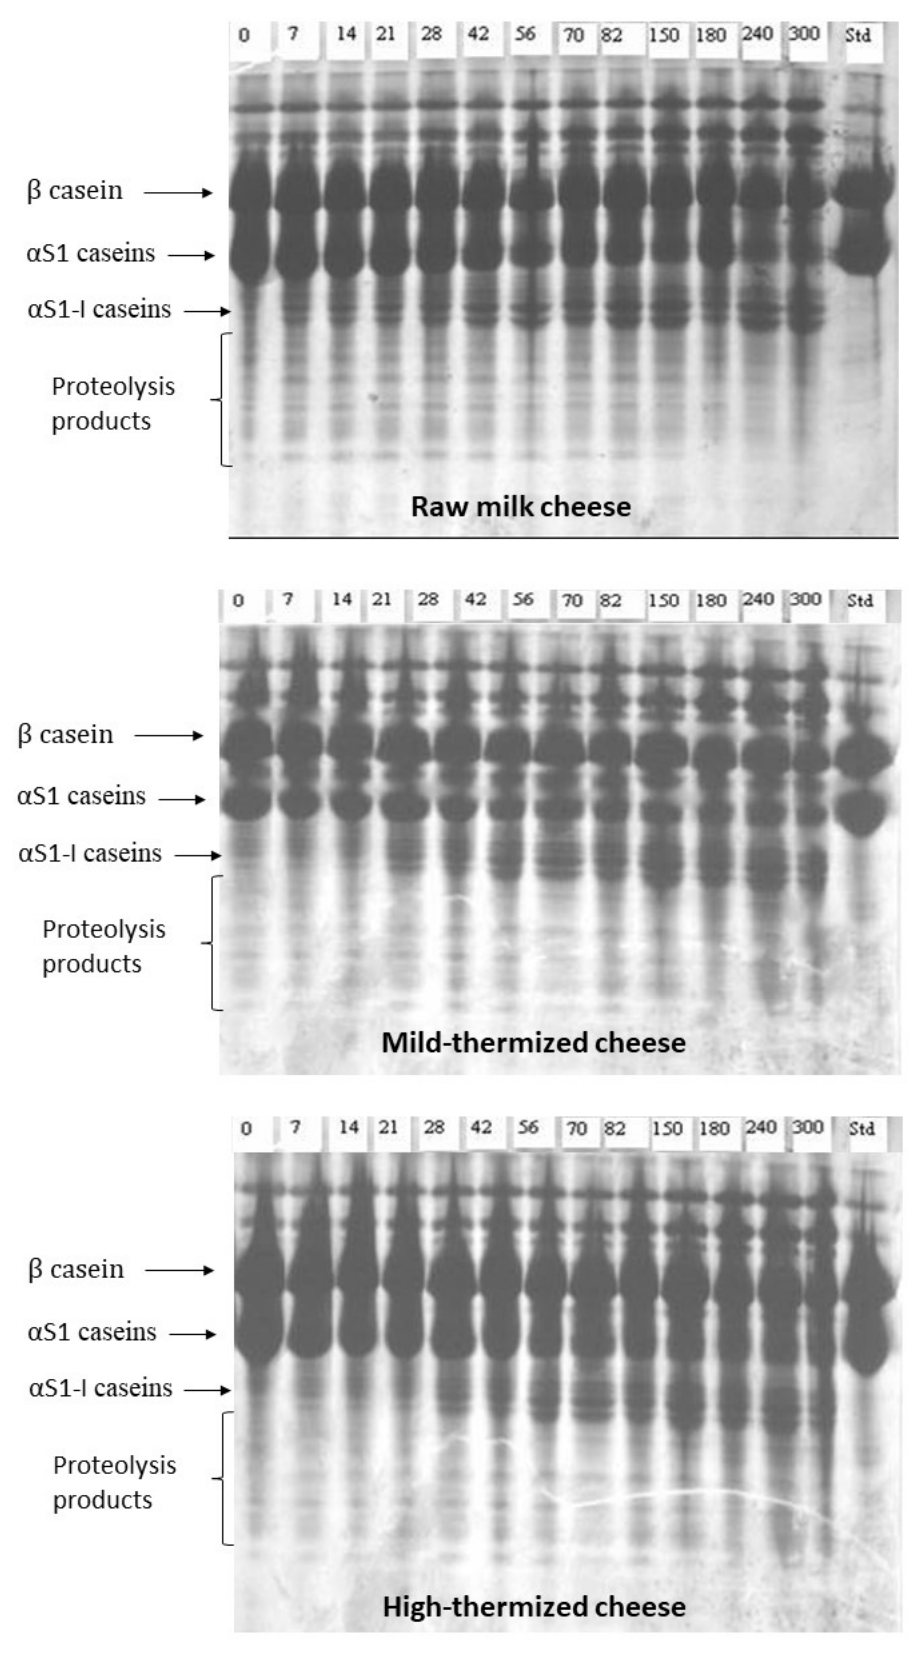
Figure 6. Urea-PAGE of Canestrato Pugliese cheese made from raw and thermized milk. Std = standard (sheep milk); from 0 to 300 = days of ripening.